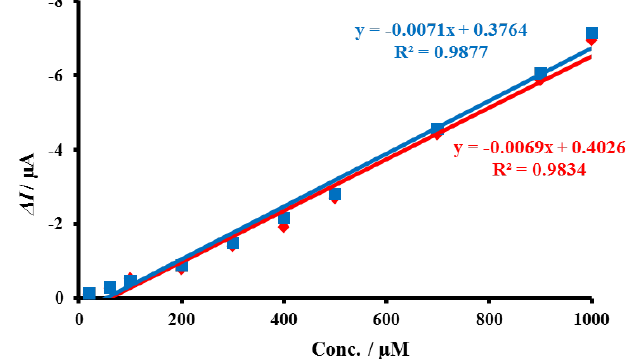
Figure 12. Stability study for the determination of H 2 O 2 (20 – 1000 µM) after 50 days (red line) using the proposed sensor (Au@TiO 2 /MWCNTs/GCE) compared to the response observed initially (blue line).